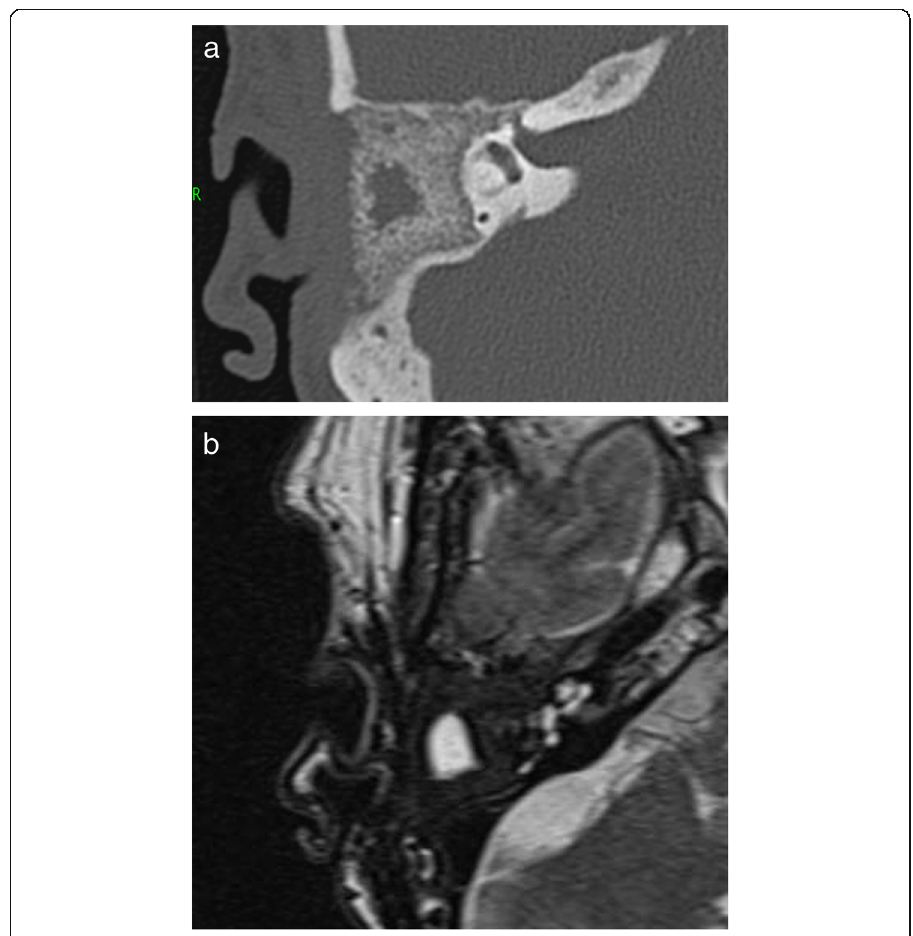
Fig. 1 a Axial CT of the right mastoid showing a homogenous distribution of the bioactive glass S53P4 in the cavity of the middle ear and mastoid with a central hypodense area considered to represent seroma or fluid. b T2-weighted axial MRI of the same